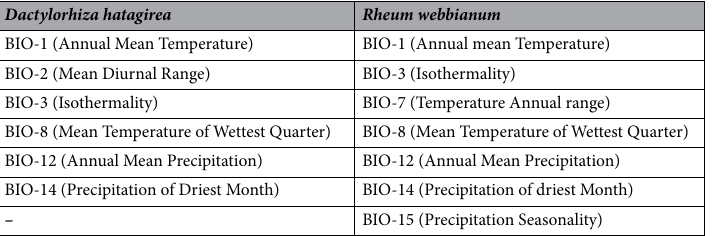
Table 9. Bioclimatic variables selected for modelling the distribution of Dactylorhiza hatagirea and Rheum webbianum in the present